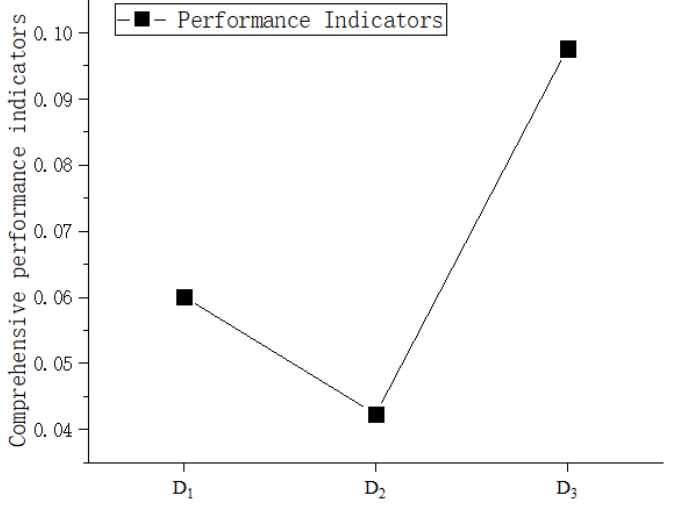
Figure 7. Comprehensive performance index values for the forming test device with different structural parameters.